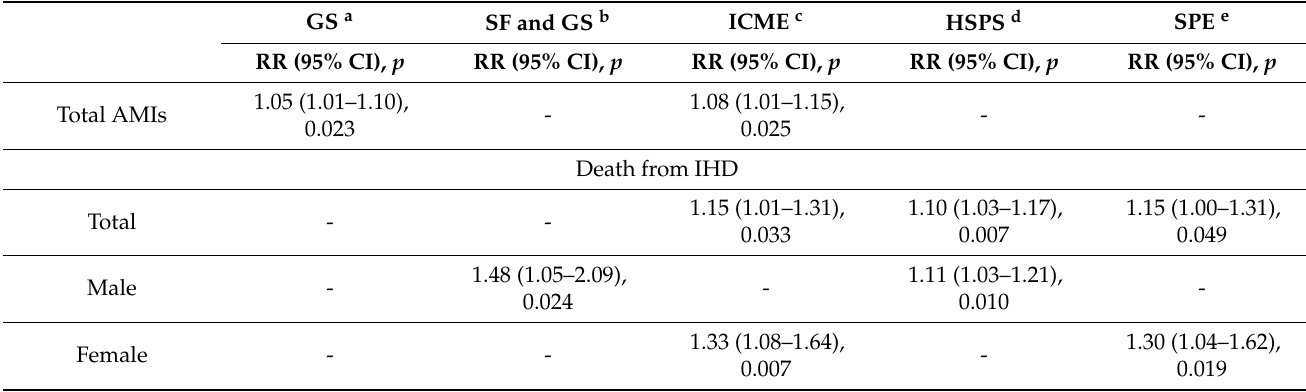
Table 10. Multivariate associations between the occurrence of AMI and death from IHD and space weather